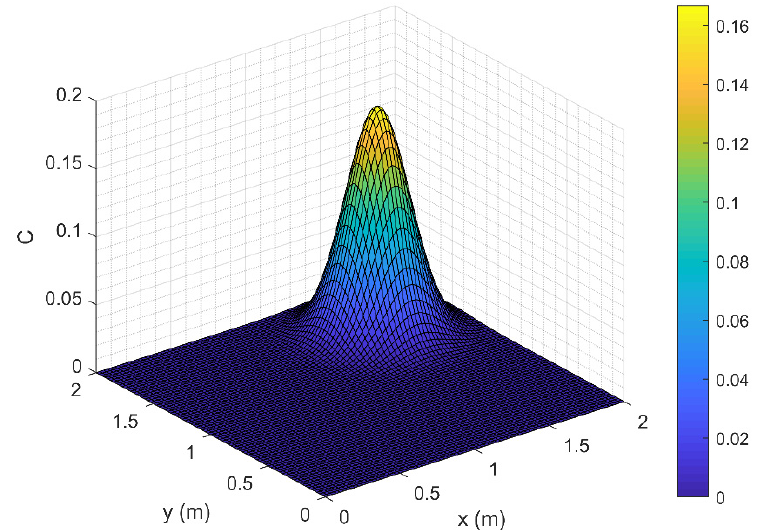
Figure 1. Approximate solution obtained with QBS-DOPRI5 at time (cid:1872) = 1.25 s with ∆(cid:1876) = ∆(cid:1877) =